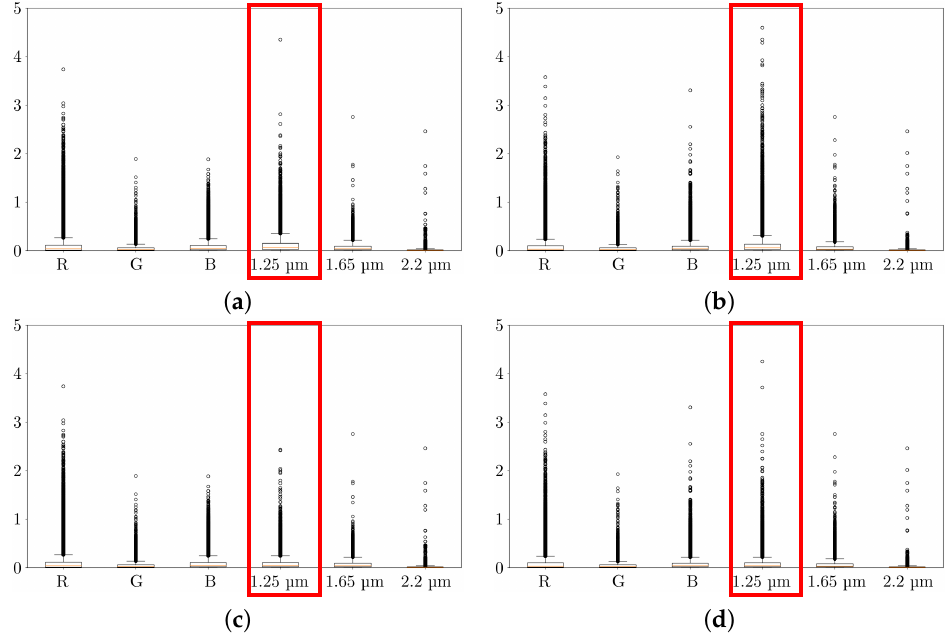
Figure 9. “Toulon” peri-urban dataset: box plots and outliers depicting the distribution of the NG criterion (not converted into percentage), for the six analysed spectral bands. ( a ) Gain-2P (0.95 µ m),